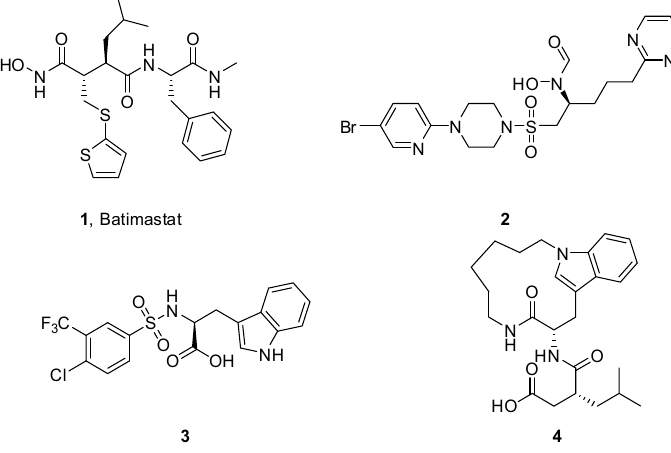
Figure 1. Structures of different MMP-7 inhibitors.